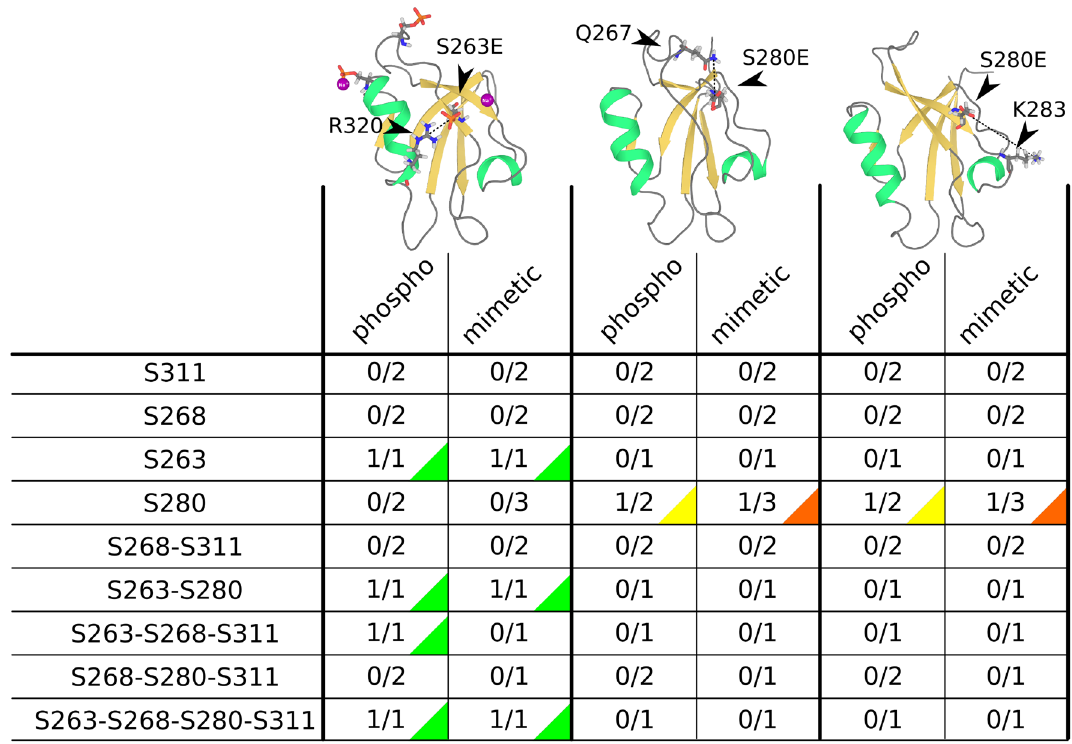
Figure 6. Occurrence of the three specific interactions (with R320, Q267, or K283) in simulations of different phospho/mimetic variants of PDZ. Each line corresponds to one phospho/mimetic variant. The columns represent specific interactions: interaction across the binding grove with R320, interaction with Q267 in the long β 2 – β 2 loop, and interaction with K283 in the short α 1 – β 2 loop. For each column, the phospho and mimetic variant are displayed on the left and the right side, respectively. The displayed rations correspond to the number of simulations with the interaction versus the total number of simulations. Each interaction was counted only when it lasted for at least of 20 ns and was present in more than 25% of the simulation time.